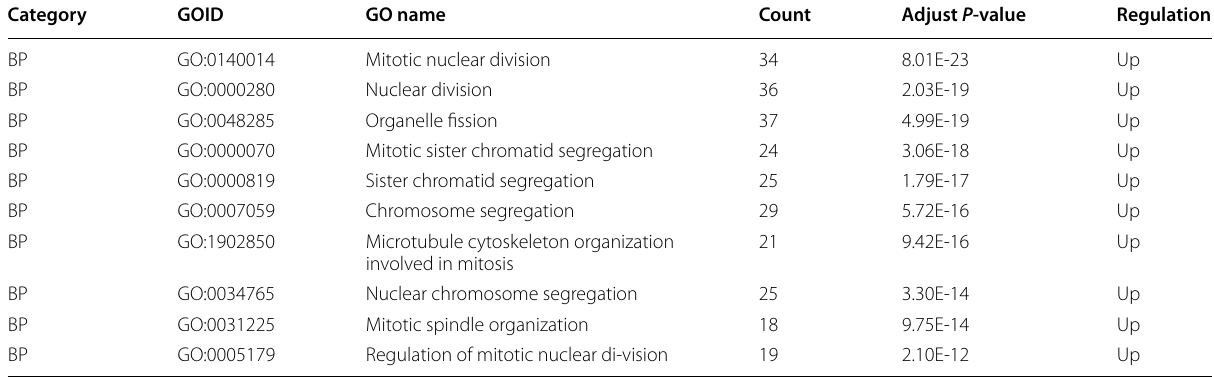
Table 2 The top enriched biological process of DEGs in the daily alcohol user group sorted by adjusted P-values in a descending order Category